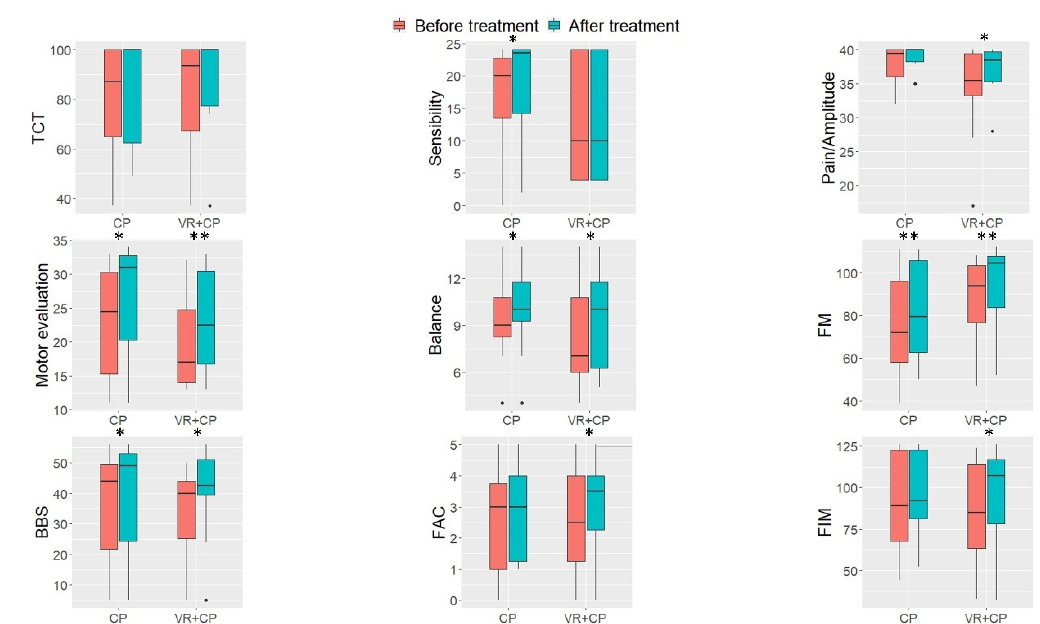
Figure 2. Boxplots of the scores obtained by the two groups of patients on each scale. TCT = Trunk Control Test; FM = Fugl-Meyer; BSS = Berg Balance Scale; FAC = Functional Ambulation Category; FIM = Functional Independence Measure. * p < 0.05, ** p < 0.01.